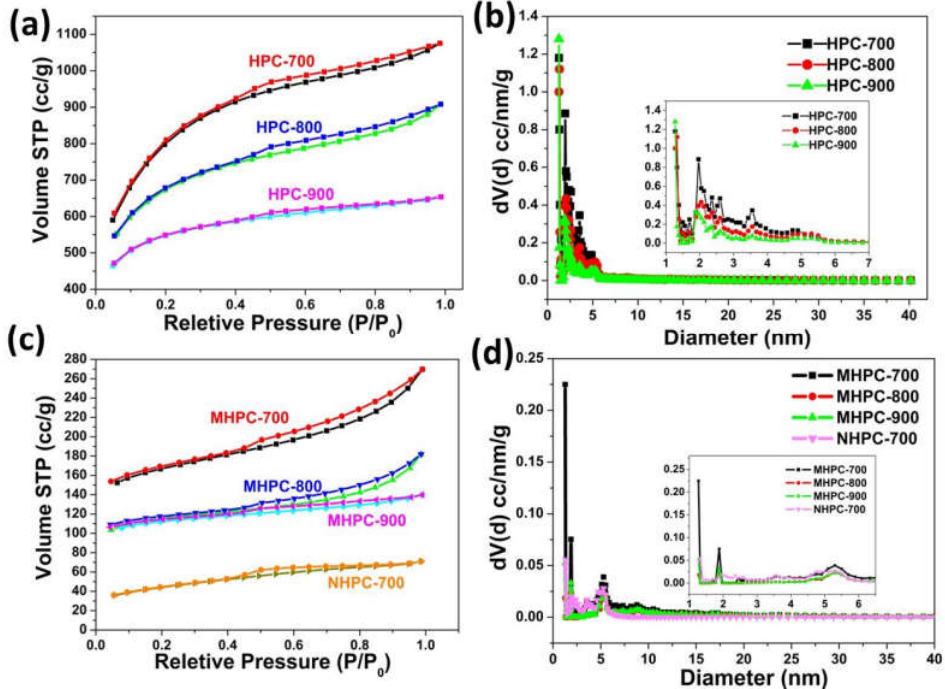
Figure 5. ( a ) N 2 adsorption/desorption isotherms and ( b ) PSDs of HPC-700, HPC-800, and HPC-900; ( c ) N 2 adsorption/desorption isotherms and ( d ) PSDs of MHPC-700, MHPC-800 MHPC-900, and NHPC-700. Table 2. Pore textural properties of the as-obtained porous carbon materials. Samples